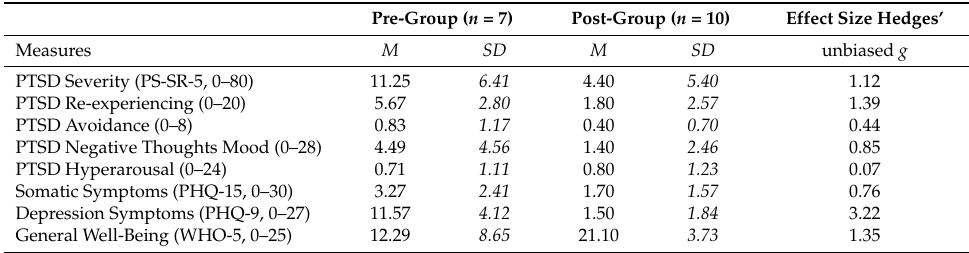
Table 2. PTSD, Somatic, Depression Symptoms, and Functioning at Pre and Post Islamic Trauma Healing